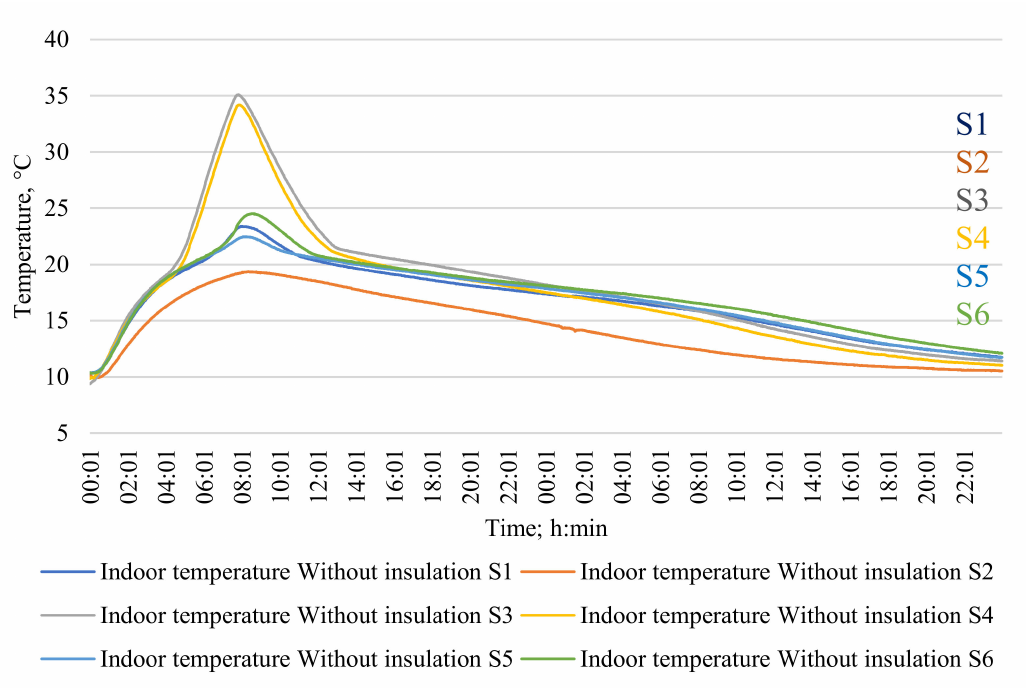
Figure 11. “Indoor” temperature in six setups without insulation applied “at